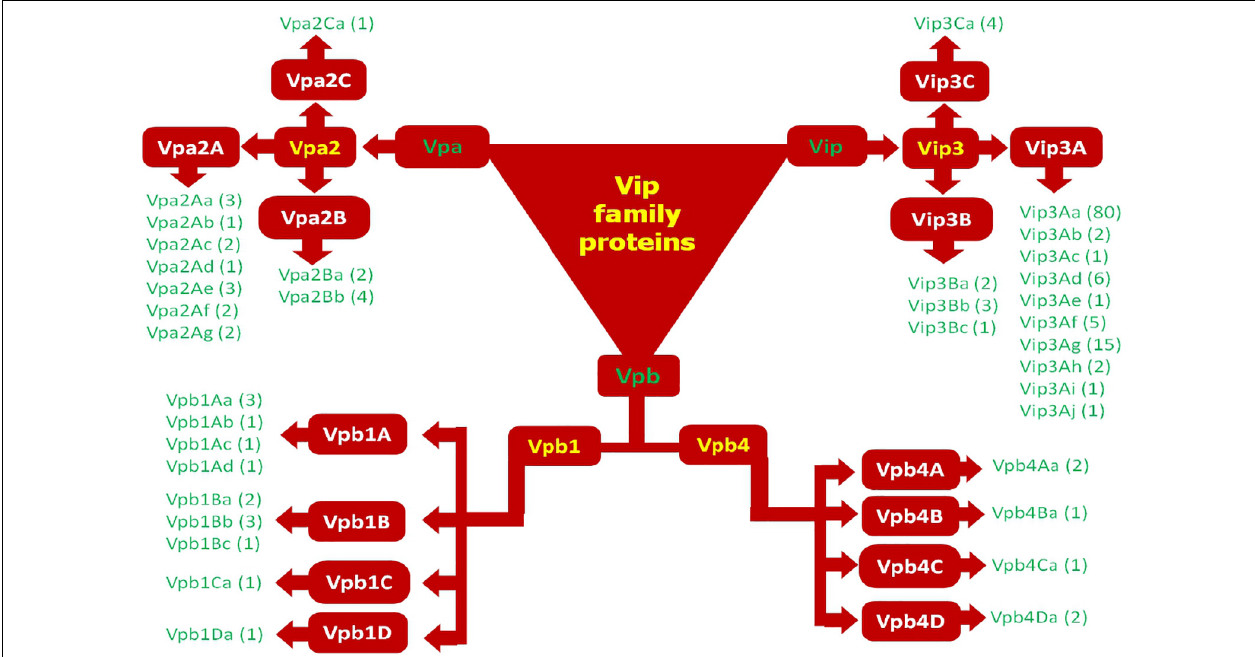
FIGURE 3 | | Modern classification of Vip family proteins (Vip1 as Vpb1; Vip2 as Vpa2; Vip3 as Vip3; and Vip4 as